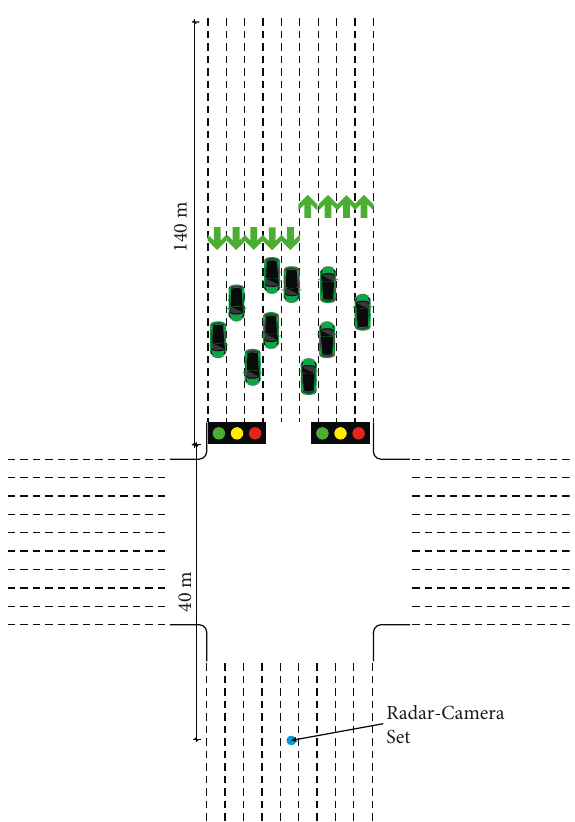
Figure 11: Crossroad typology. Table 4: Incident detection results in crossroad